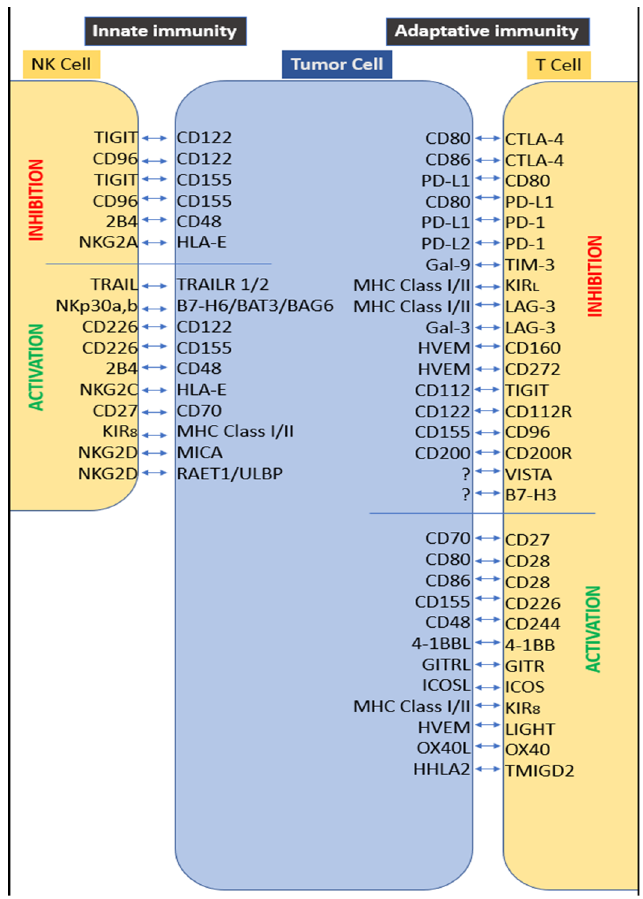
Figure 1. Immune checkpoints in the tumor microenvironment. This figure presents the main immune checkpoints, as membrane ‐ expressed molecules, regulating the immune response in the tumor microenvironment. These immune checkpoints could have activating or inhibiting actions on natural killer cells (NK) or T ‐ cells, influencing the innate or adaptative immunity.